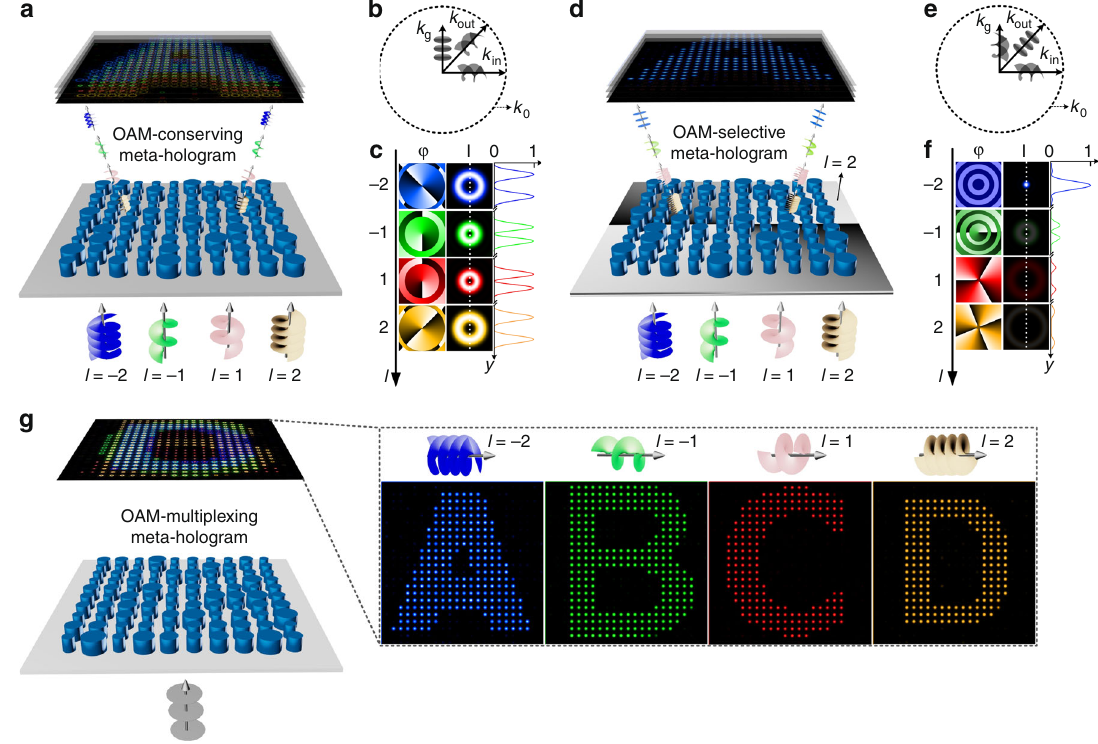
Fig. 1 Principle of metasurface OAM holography. a Schematic of an OAM-conserving meta-hologram capable of transferring the OAM property from an OAM incident beam to a holographic image. b Schematic illustration of the OAM property transfer in the spatial frequency domain ( k -space). c The phase ( φ ) and intensity ( I ) distributions of single pixels in the reconstructed holographic images, respectively. Pseudo colors are used to visualize different OAM modes. d Schematic of an OAM-selective meta-hologram sensitive to a given OAM mode. e Schematic illustration of the OAM conversion from an incident OAM beam to a fundamental spatial mode after passing through an OAM-selective meta-hologram. f The phase ( φ ) and intensity ( I ) distributions of single pixels in the reconstructed holographic images using different OAM modes. High intensity is achieved in each pixel whenever the incident light has a topological charge matching the design of the interface. g Schematic of an OAM-multiplexing meta-hologram capable of reconstructing multiple distinctive OAM-dependent holographic